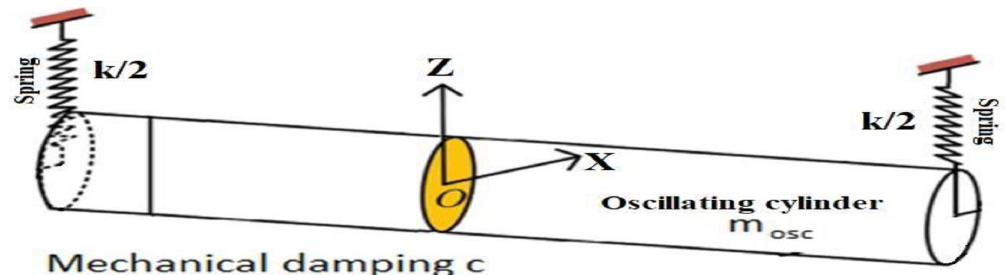
Figure 3. A cylinder is totally submerged in water with two springs attached at both ends. Springs are not required for vortex-induced vibrations to oscillate the cylinder but they help in regulating its motion. This system can be mathematically defined by the widely known equation 𝑚 (cid:3042)(cid:3046)(cid:3030) 𝑧(cid:4663)(cid:4666)𝑡) + 𝑐𝑧(cid:4662)(cid:4666)𝑡) + 𝑘𝑧(cid:4666)𝑡) = 𝐹 (cid:3033)(cid:3039)(cid:3048)(cid:3036)(cid:3031) (cid:4666)𝑡) (1) where m osc represents the total oscillating mass (all moving parts including one third of spring mass), c the mechanical damping, k the total spring stiffness and the F fluid (t) force applied on the cylinder by the fluid. Z(t) is the vertical displacement of the cylinder and its derivatives 𝑧(cid:4662)(cid:4666)𝑡) and 𝑧(cid:4663)(cid:4666)𝑡) are its velocity and acceleration, respectively. 𝑧(cid:4666)𝑡) , 𝑧(cid:4662)(cid:4666)𝑡) , 𝑧(cid:4663)(cid:4666)𝑡) and F fluid (t) are functions of time, as the notations imply. As the fluid continues to flow, it generates F fluid (t) on the cylinder which leads to continuous cylinder oscillation. Mass ratio, which is defined as ratio of oscillating mass/mass of oscillating parts of the system to displaced mass, is calculated with the following equation: